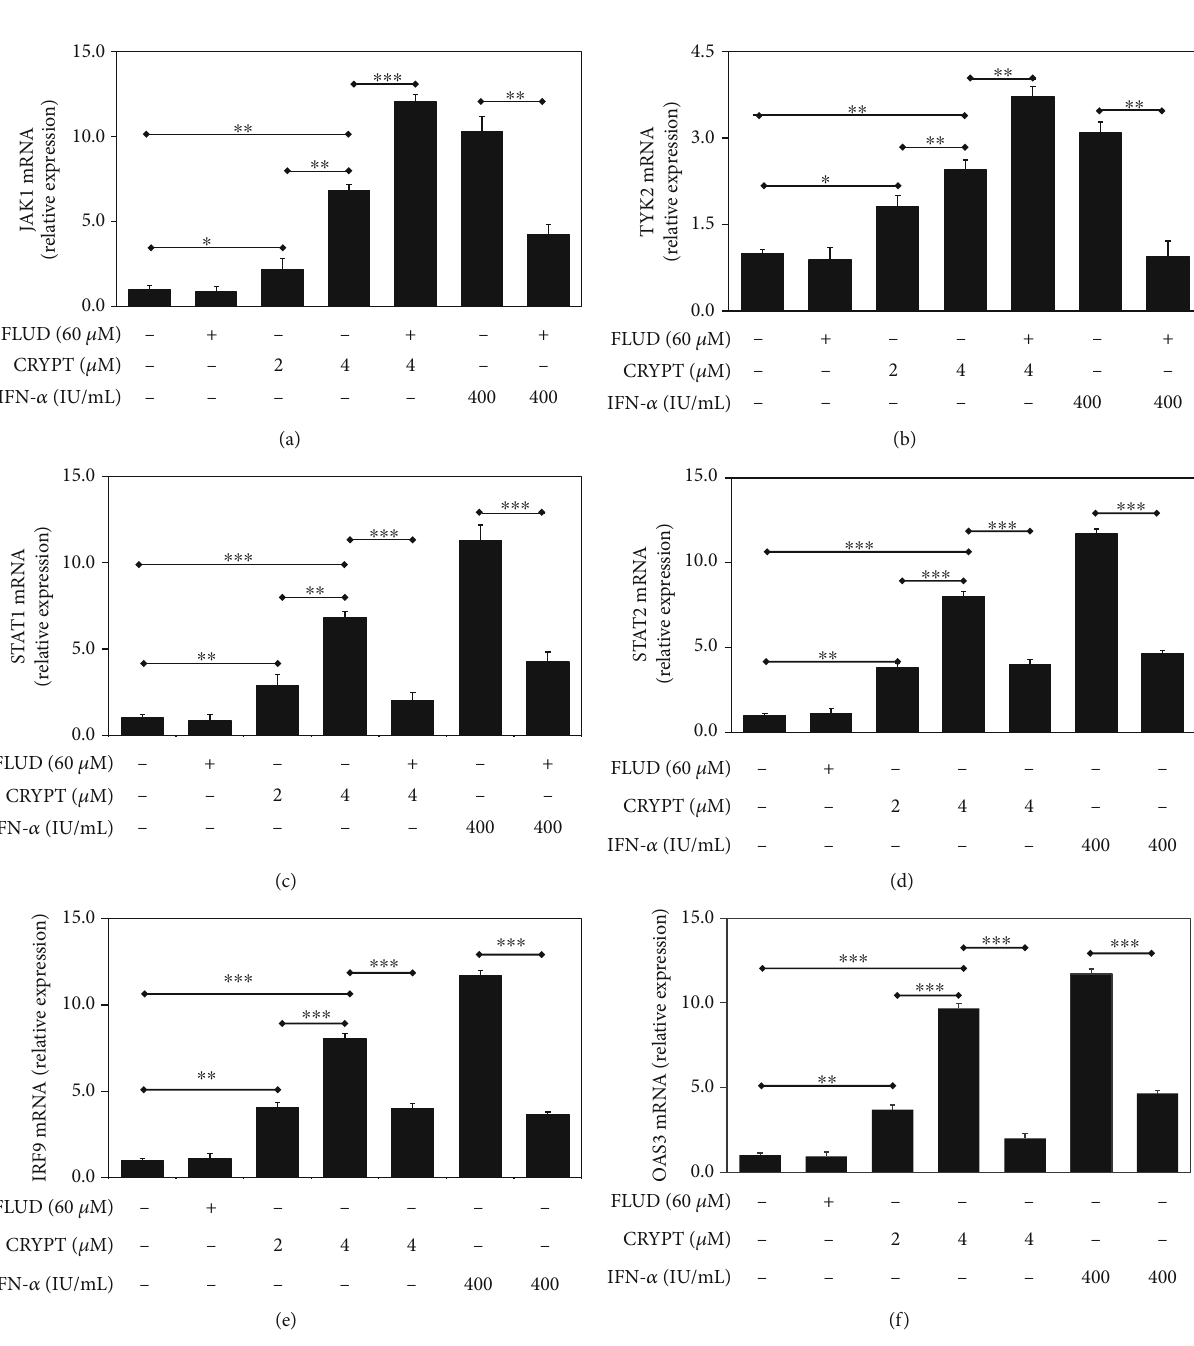
Figure 2: Cryptolepine increases JAK1 , TYK2 , STAT1 , STAT2 , IRF9 , and OAS3 mRNA levels in THP1-derived macrophages. The derived macrophages from the parent THP1 cells were cultured with cryptolepine (CRYPT), fl udarabine (FLUD), or IFN- α as indicated. The target genes were assessed after 24 h by RT-qPCR with gene-speci fi c primers and probes using β -actin as an endogenous control. Data are shown as the means, from three varied experiments with each done in triplicate, and error bars represent the standard deviations. ∗ p < 0 : 05 , ∗∗ p < 0 : 01 , and ∗∗∗ p < 0 : 001 (one-way ANOVA and Bonferroni ’ s